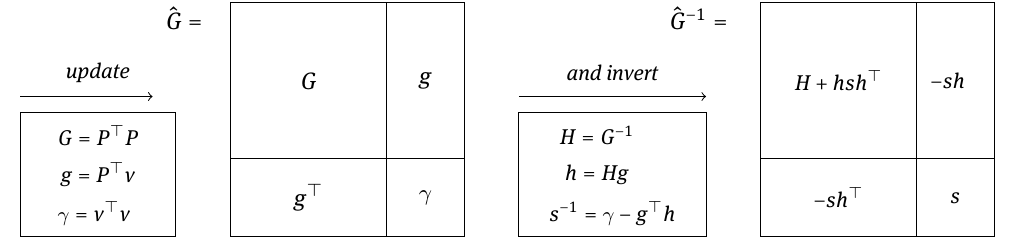
Figure 13: Updating the inverse of an updated